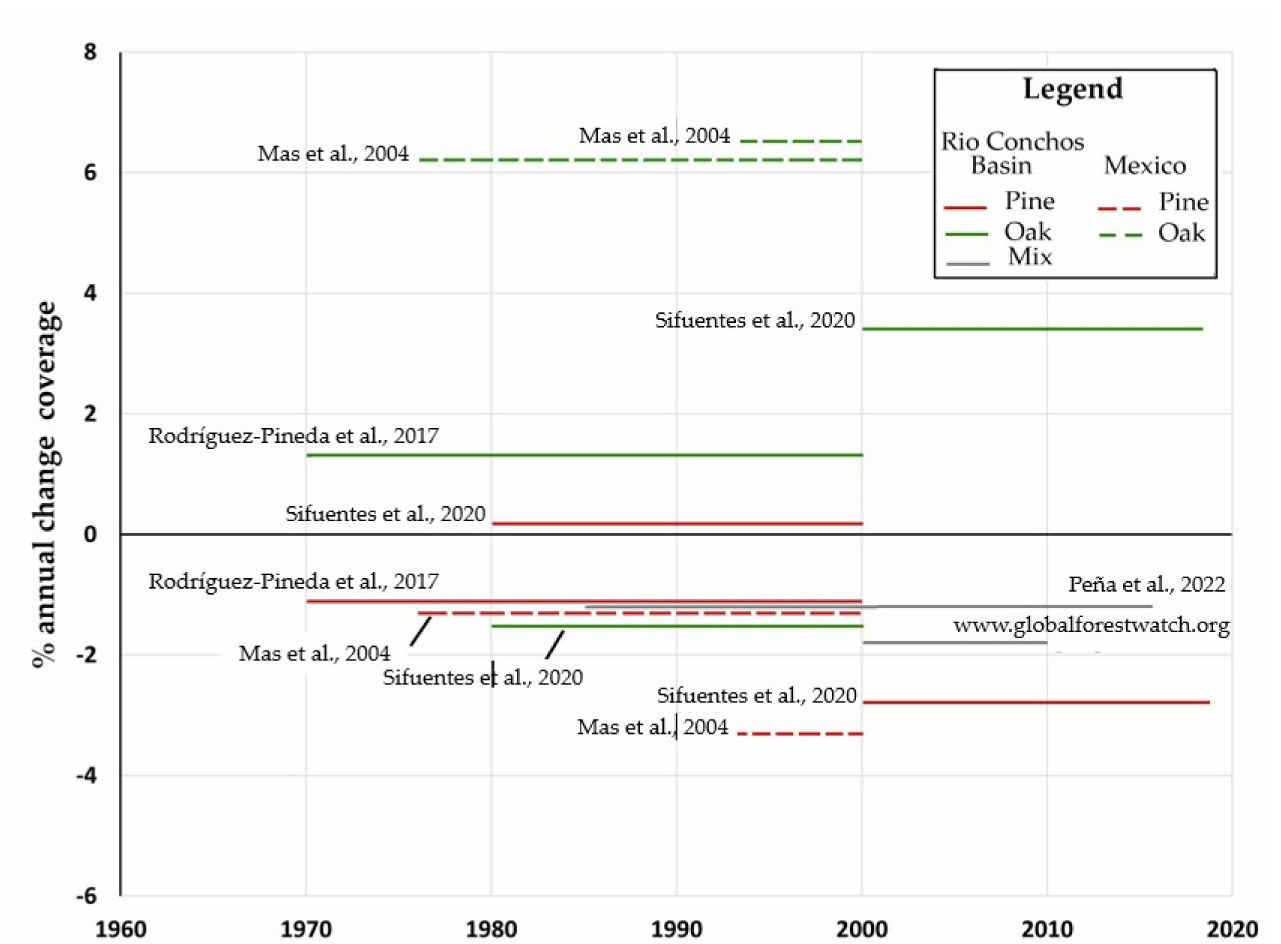
Figure 3. Percent annual change of forest cover reported for the Rio Conchos basin (solid lines) and Mexico’s temperate forests (dashed lines)